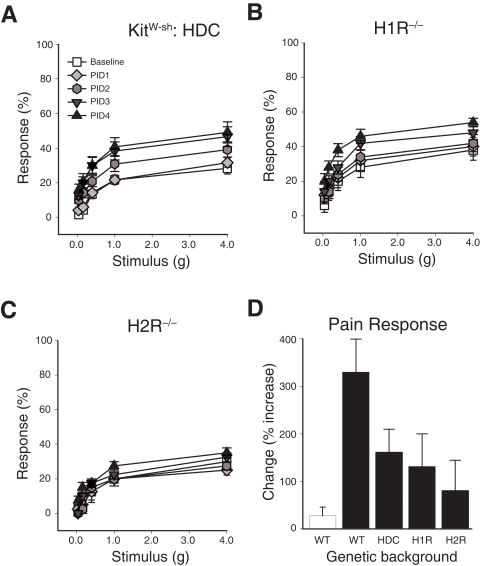
Histamine mediates cystitis pain.A) KitW-sh/KitW-sh mice reconstituted with HDC−/− marrow exhibit reduced pelvic sensitivity following PRV infection (n = 12). Enhanced pelvic sensitivity relative to baseline (P<0.05) was delayed until PID3. B) H1R−/− mice exhibit reduced pelvic sensitivity following PRV infection (n = 12). Enhanced pelvic sensitivity relative to baseline (P<0.05) was delayed until PID4. (n = 5). C) H2R−/− mice did not develop enhanced pelvic sensitivity following PRV infection (n = 4). D) Mice deficient for HDC, H1R, or H2R exhibit diminished pelvic sensitivity at PID 4 relative to WT mice. Percent responses at PID4 calculated as total responses to all fibers relative to baseline responses for sham-infected (white bar) and PRV-infected mice (black bars). The symbol key shown in (A) applies to panels A–C. Error bars depict SEM, and significance was determined by ANOVA.